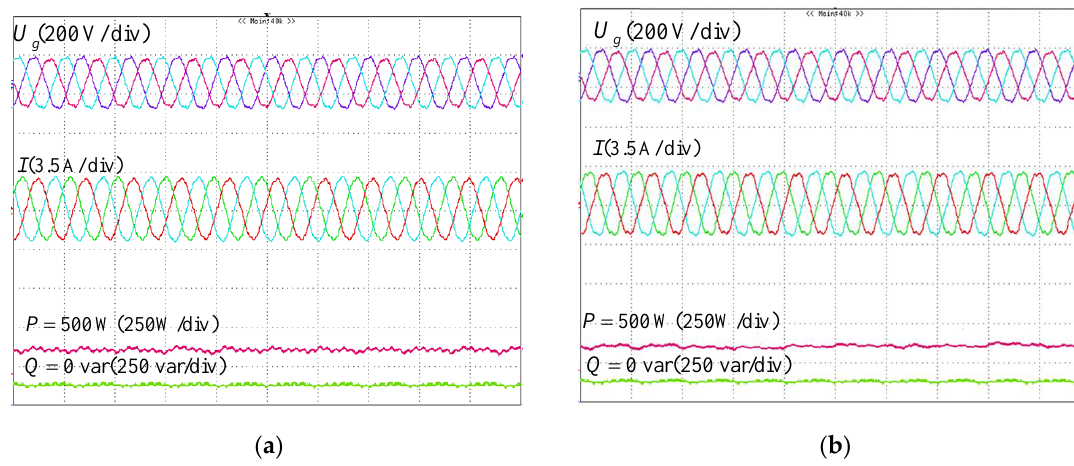
Figure 13. Operation of VSC under inter-harmonics grid with the proposed control. ( a ) Target I sinusoidal current; ( b ) Target II, steady power without ripples.